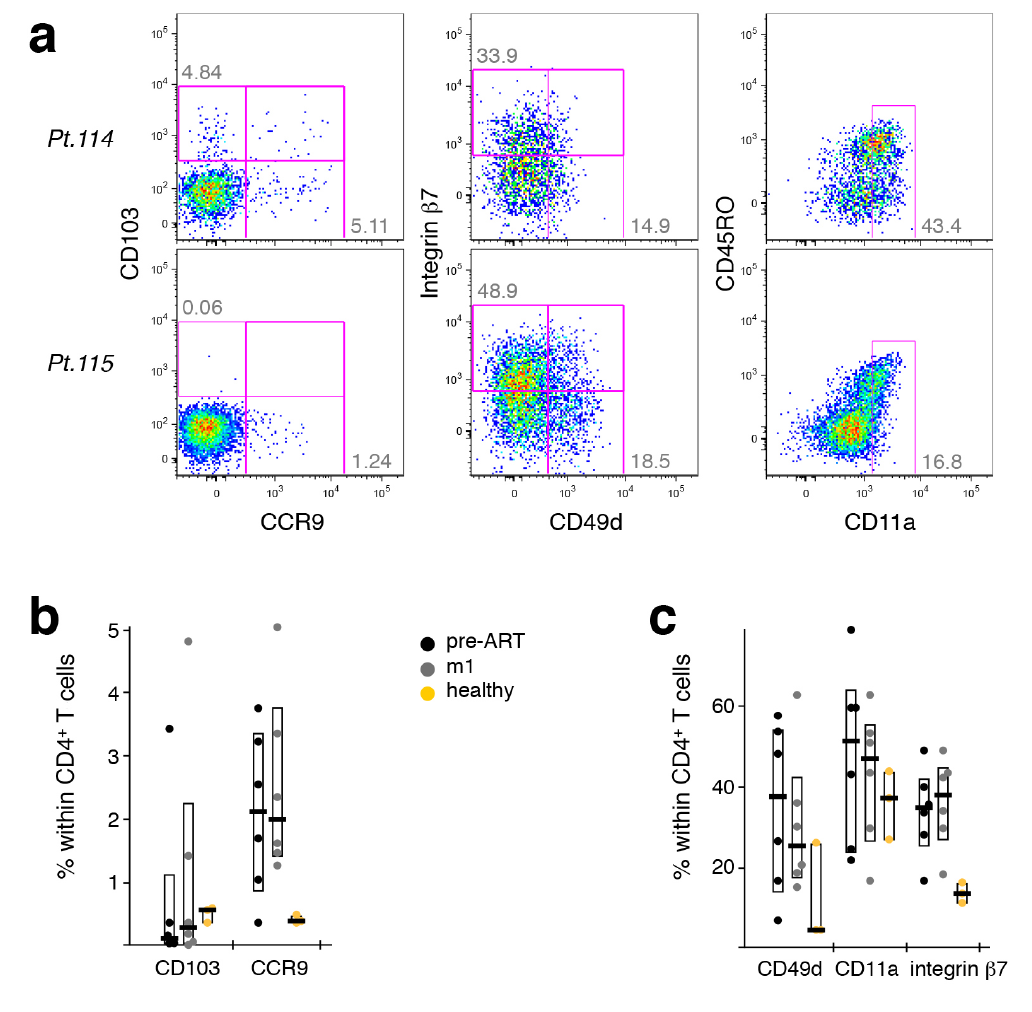
Supplementary Figure 6. Migration marker expression on CD4 + T cells. The expression of migra- tion markers on the cell surface of CD4 + T cells was investigated by flow cytometry. (A) Dot plots show the expression of CD103, CCR9, integrin β 7, CD49d, and CD11a on CD4 + T-cells from two different patients after 1 month of ART. (B) CD103 and CCR9 expression pre-ART and after 1 month of ART compared to healthy donors. (C) CD49d, CD11a, and integrin β 7 expression pre-ART and after 1 month of ART compared to healthy donors. Bar graphs show interquartile ranges, median bars, as well as individual data points. Due to the small sample size, no statistical comparison was